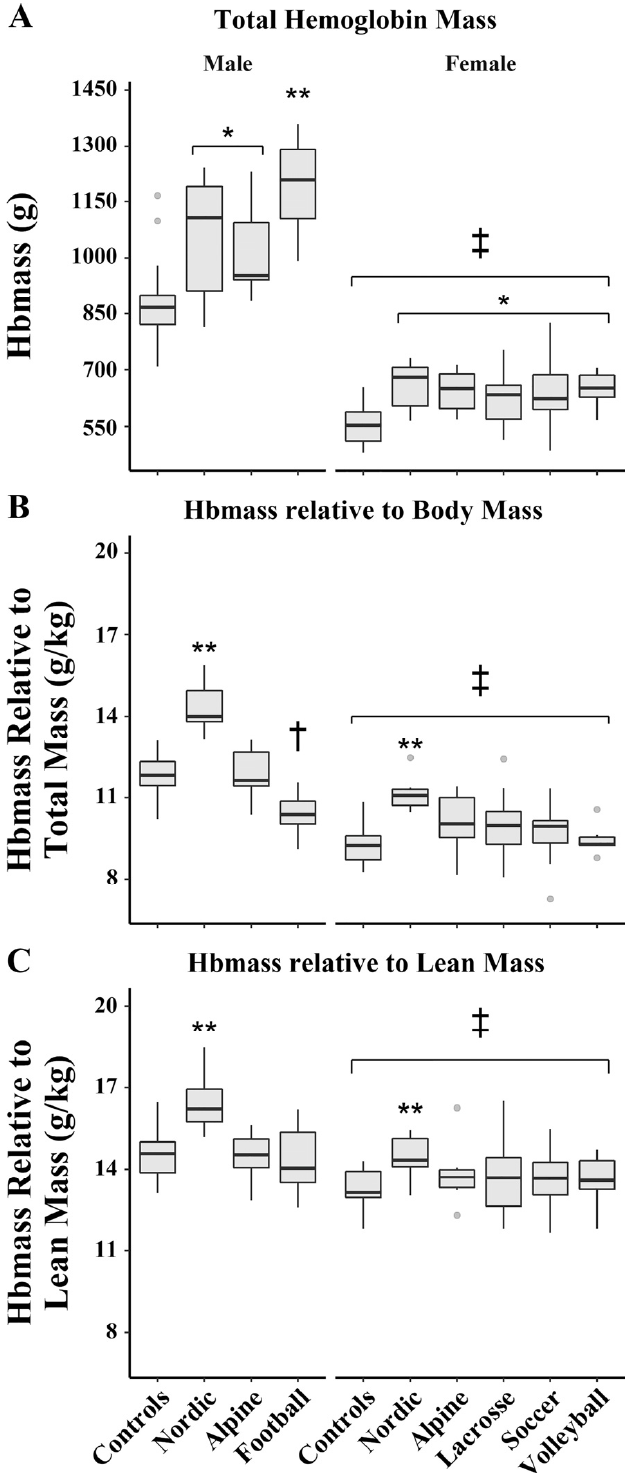
Figure 7. Reprinted with permission from ref. [86]. 2020 the American Physiological Society. Differ- ences in total hemoglobin mass ( A ), hemoglobin mass relative to total body mass ( B ), and hemoglobin mass relative to lean mass ( C ). * Significantly higher than sex-matched control subjects; ** significantly higher than all other sex-matched groups; † significantly different from control and alpine; ‡ significantly lower than male subjects.